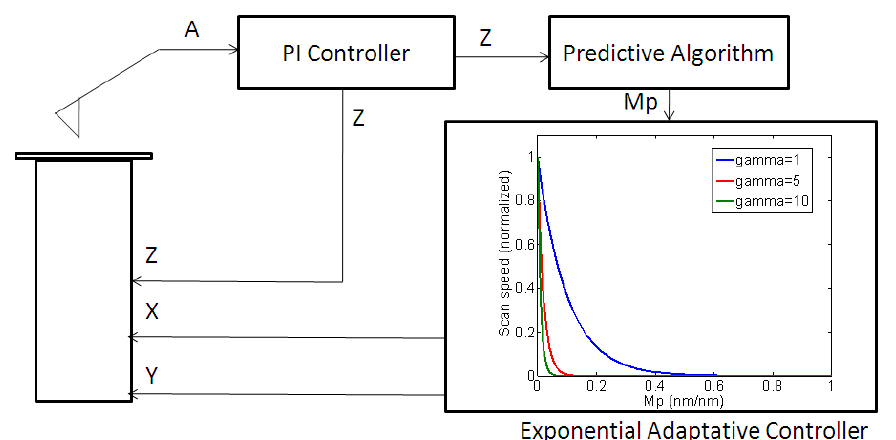
is the predicted p